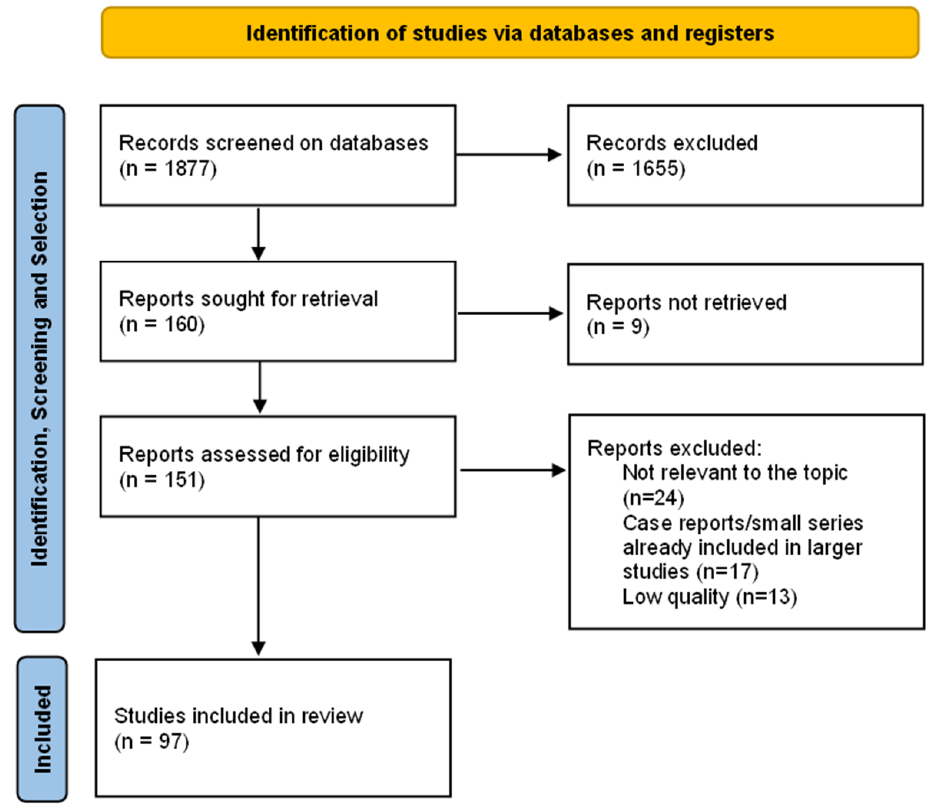
Figure 2. Flow diagram of the literature research, screening, selection and final inclusion in the final analysis.